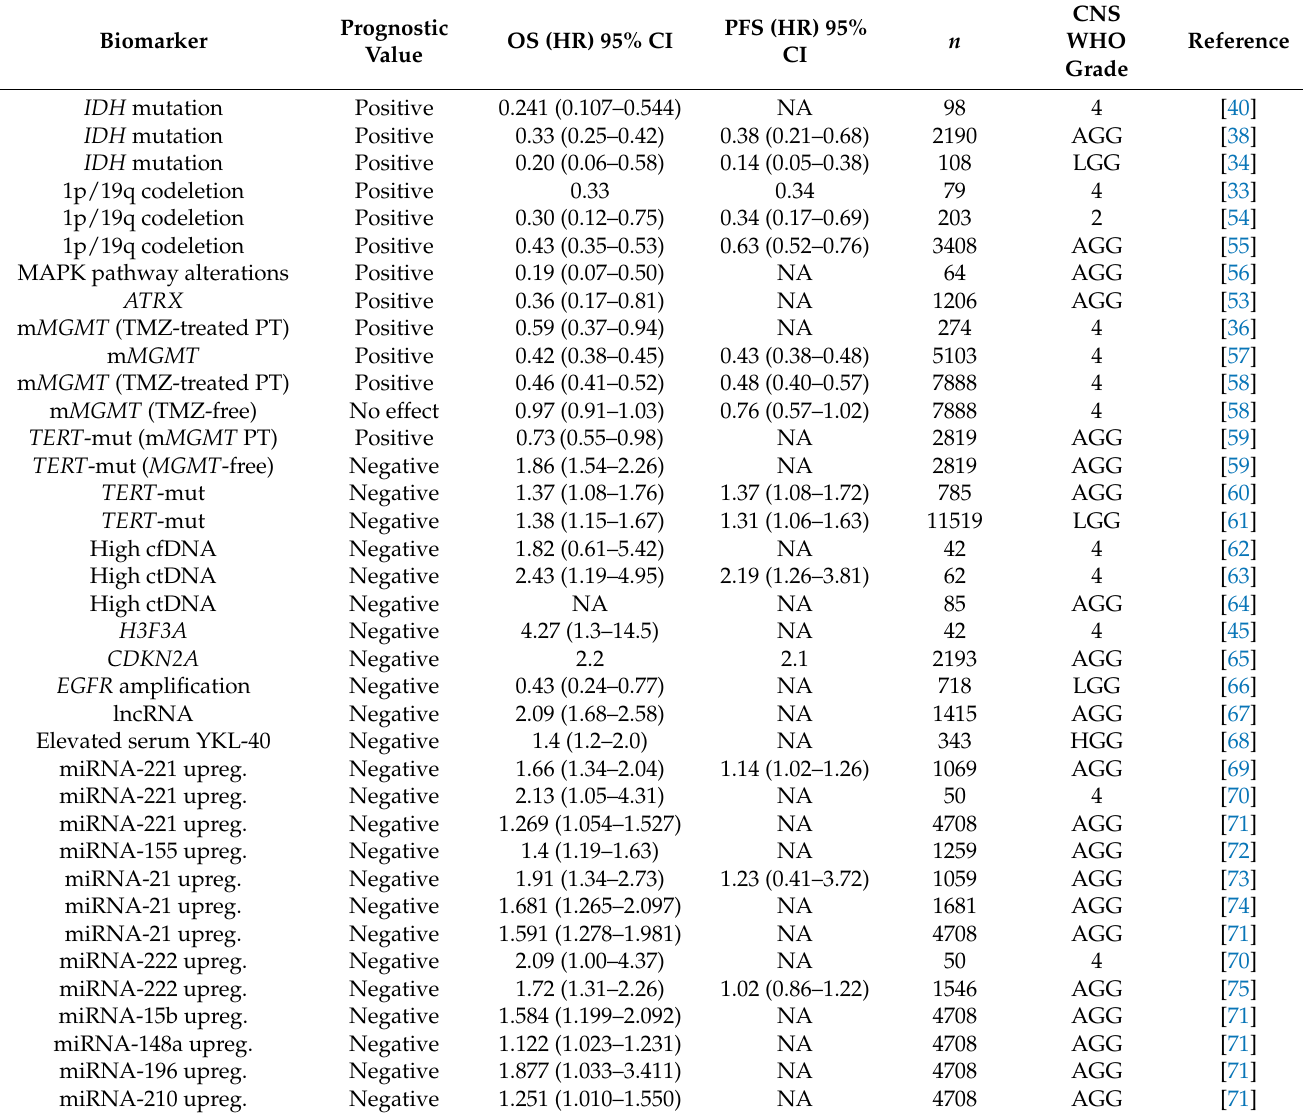
Table 2. Prognostic biomarkers in